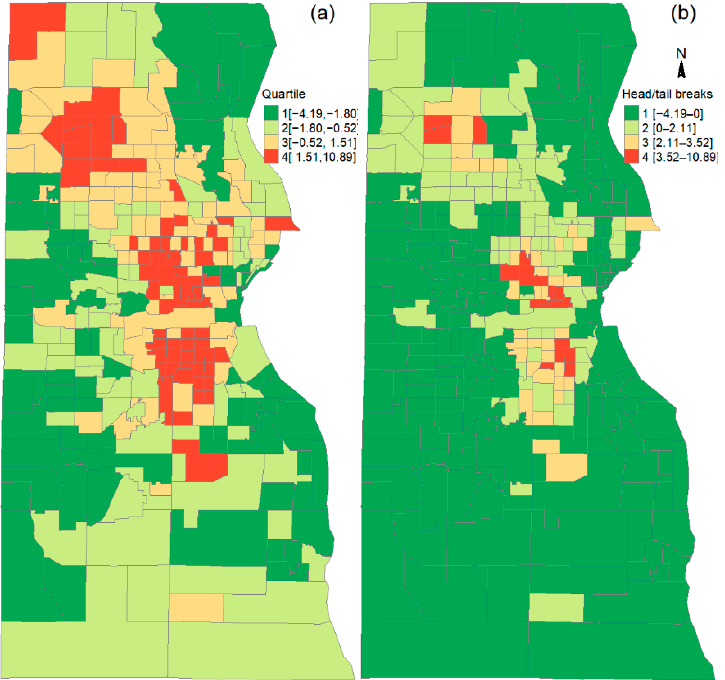
Figure 3. Spatial distribution of high and low social vulnerability areas based on ( a ) quartile and ( b ) head/tail breaks classification of the social vulnerability index. The red color (i.e., the fourth quarter or the large-value head class) represents high social vulnerability, and the green color (i.e., the first quarter or the small-value tail) represents low social vulnerability.